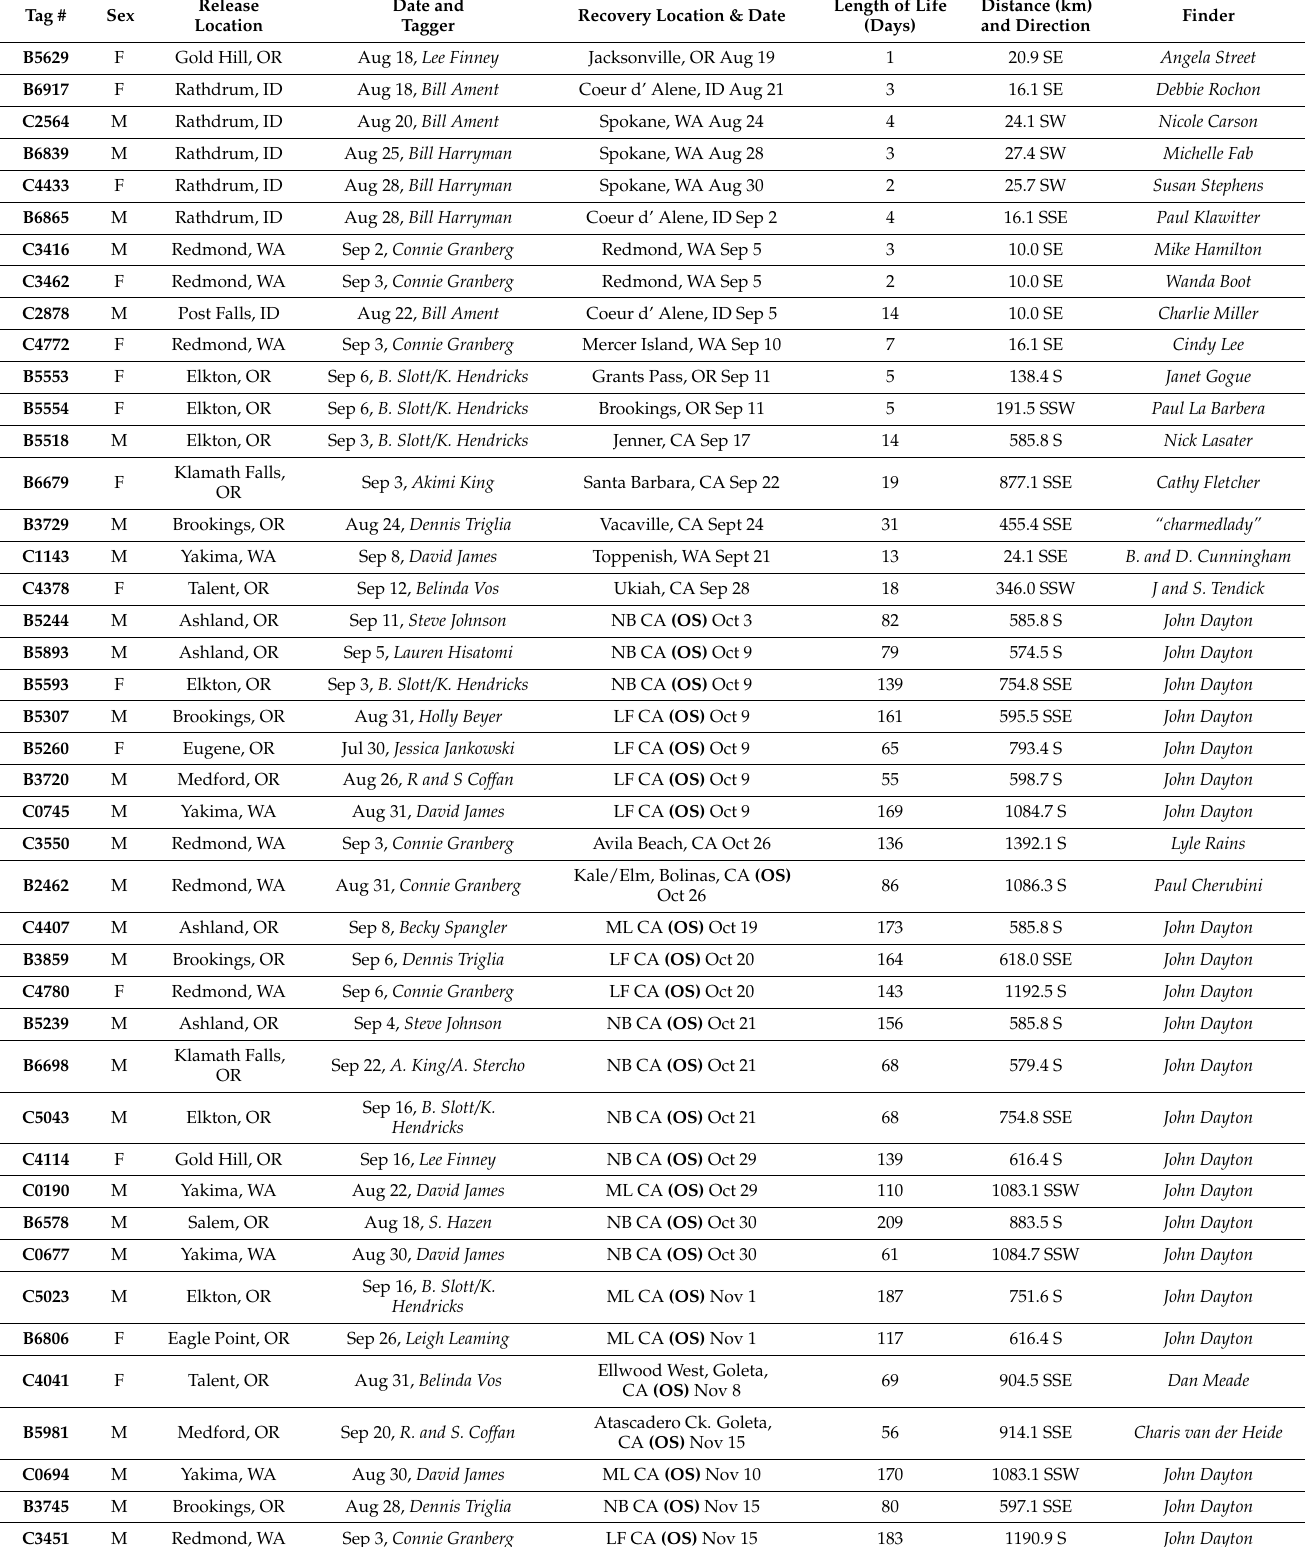
Table 2. Release, recovery, distance, direction and lifespan data for monarchs, captive-reared, tagged and released in the PNW during 2017. OS = overwintering site. Santa Cruz overwintering sites: LF = Lighthouse Field State Beach, NB = Natural Bridges State Beach, ML = Moran